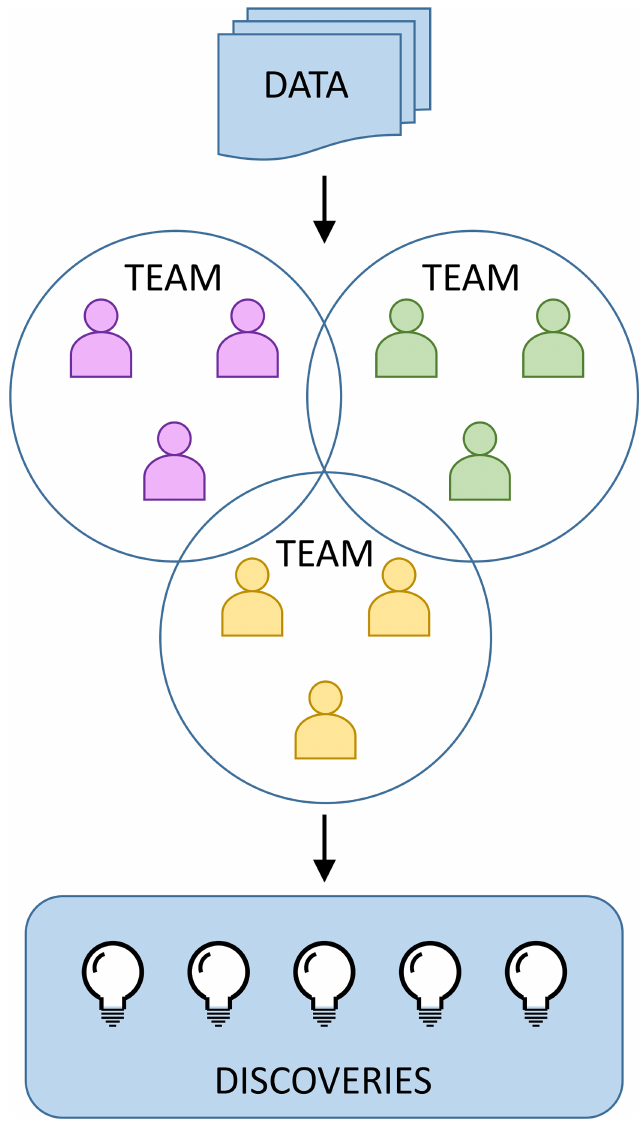
Fig 1. Stimulation of innovation in U4C. Existing genome-wide associationstudies (GWAS), representing thousands of cases and controls. Data were shared and accessedin a manner consistent with informed consent. Some of these data sets were made availablefor the first time in U4C. Teams competedfor a prize to developinnovativeanalyticalmethods and make novel discoveries using these data sets.